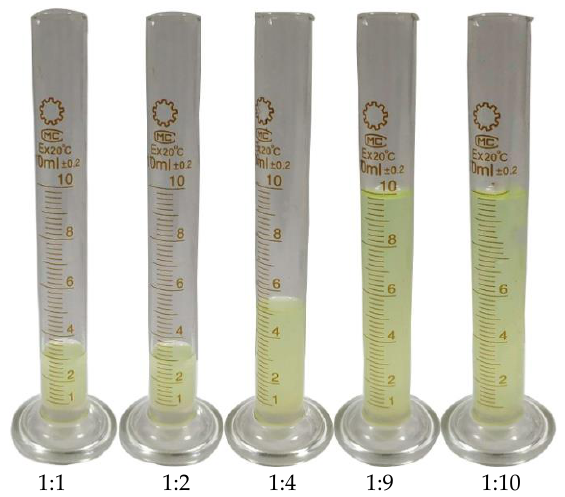
Figure 5. Mixing effect of different volume ratios of reaction products and diesel.